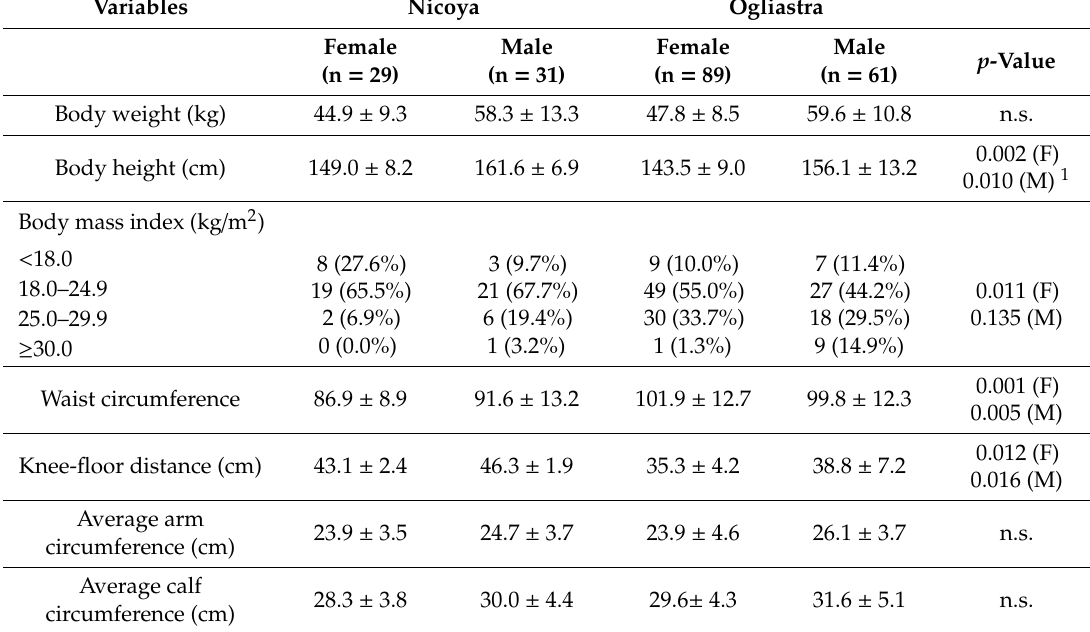
Table 2. Anthropometric parameters in 210 Nicoyan and Sardinian participants.